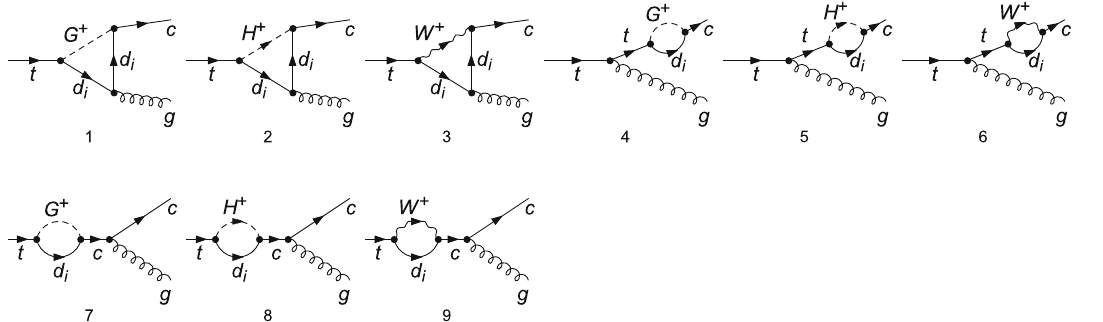
Fig. 1 One-loop Feynman diagrams contributing to the t → cg decay in the ’t Hooft–Feynman gauge, with d i = { d , s , b } , in the A2HDM. The first 1–3 diagrams are the vertex diagrams, and the rest 4–9 are the t − c fermion self-energy